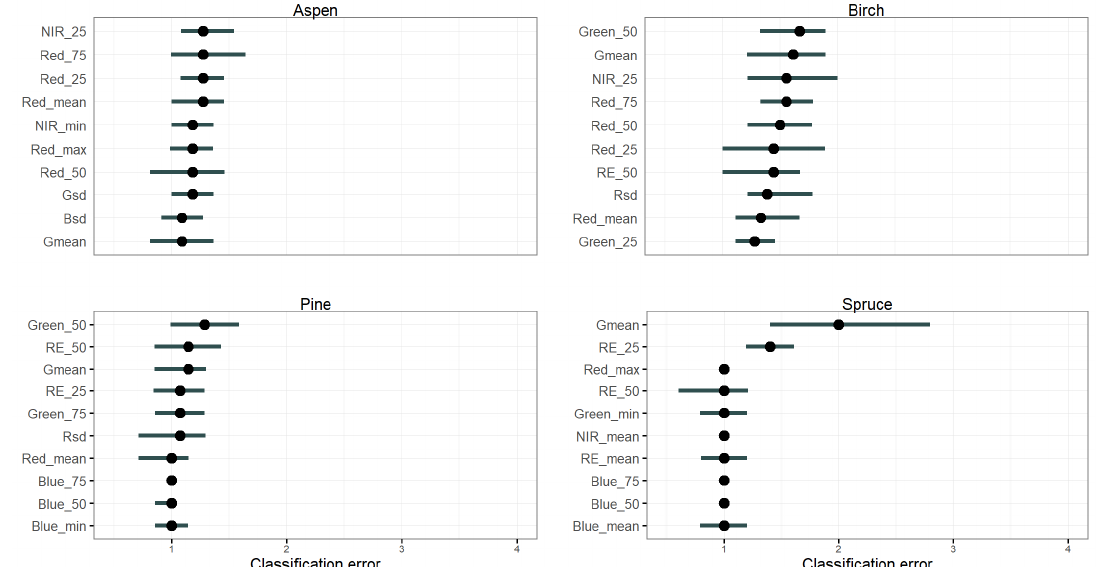
Figure 4. Permutation feature importance for classification of the 4 tree species applying the SVM model for the MicaSense dataset (10 most important features).